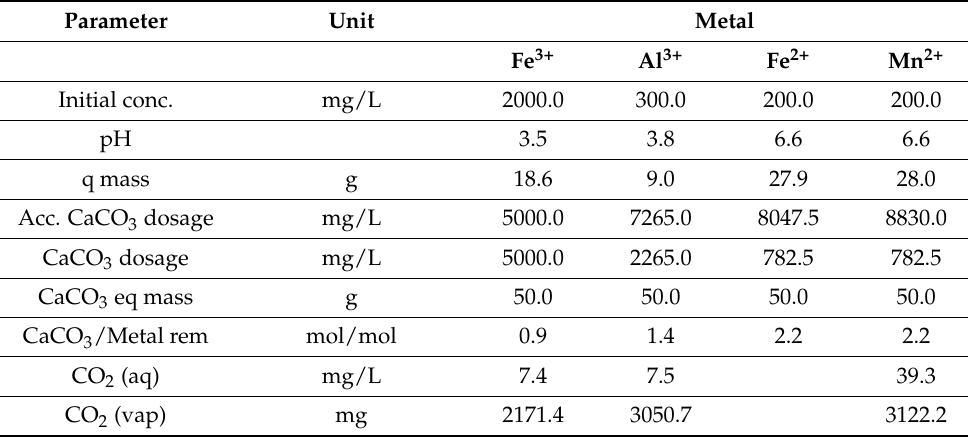
Table 9. Mole ratio of Alkali dosage/Metals removed at 0.1